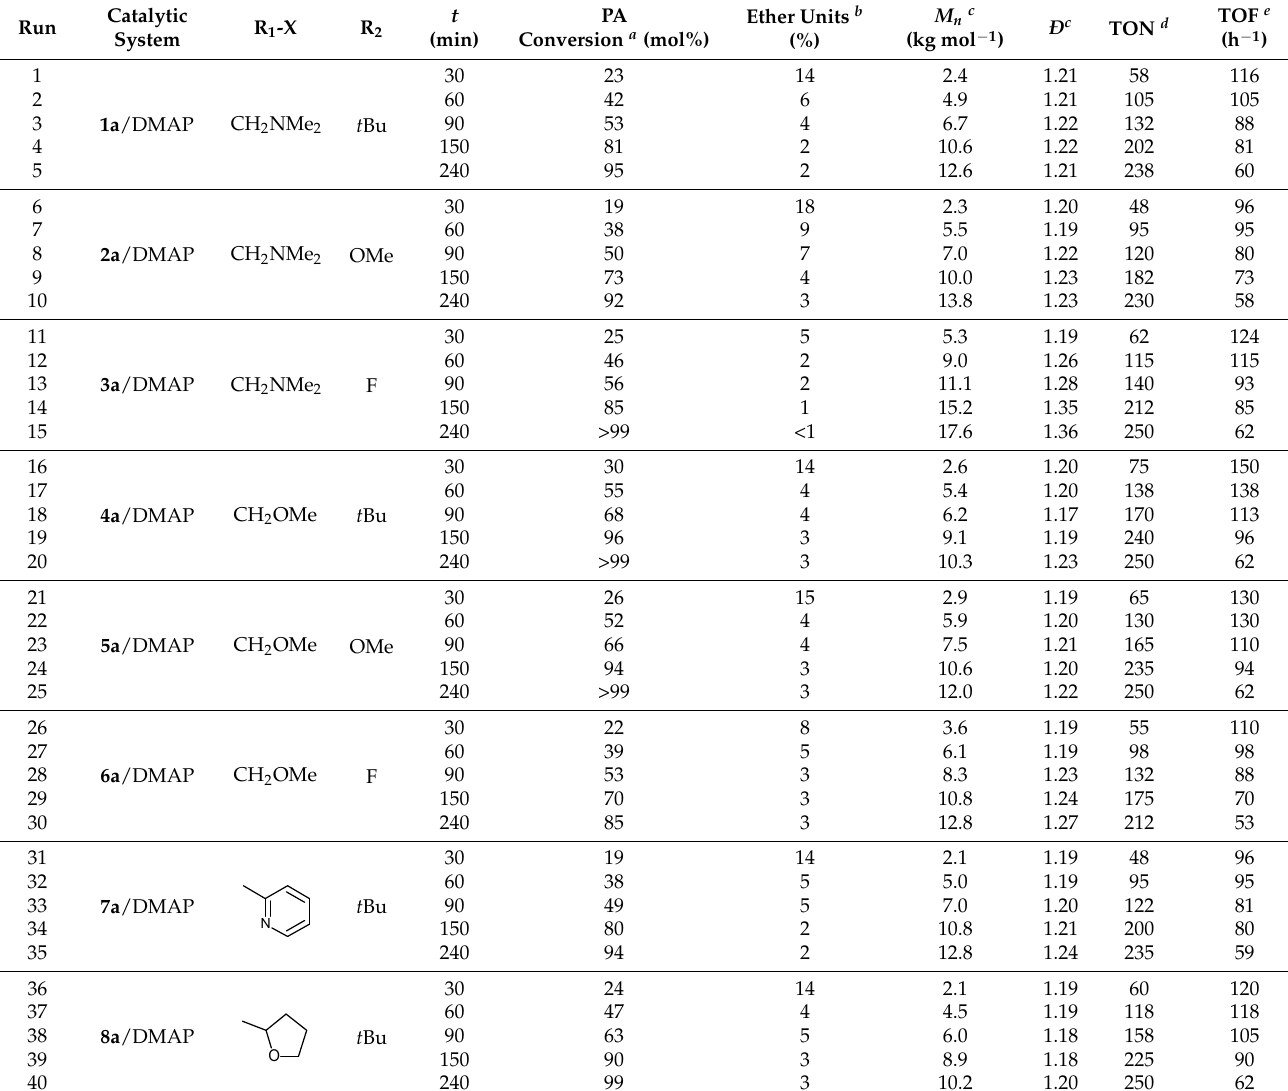
Table 2. Results obtained for the ROCOP reactions between phthalic anhydride (PA) and cyclohexene oxide (CHO carried out in the presence of different amine-bis(phenolate) chromium(III) complexes and DMAP. Catalytic Run